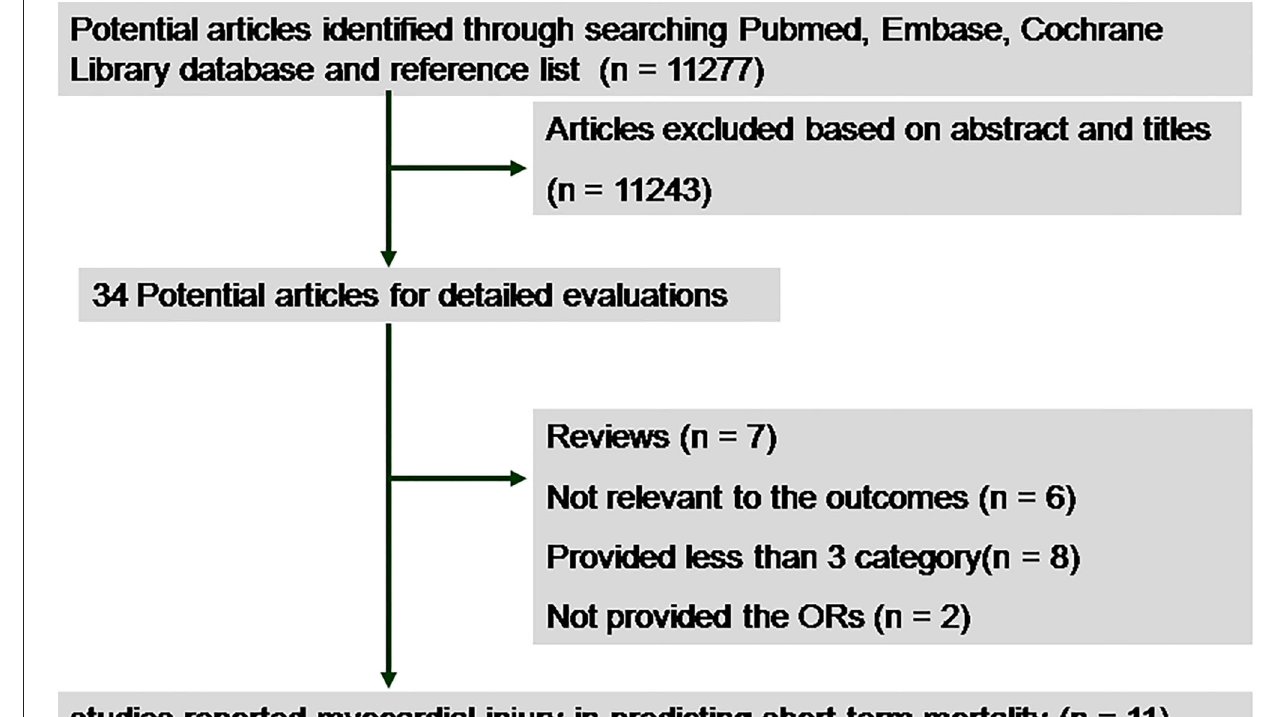
FIGURE 1 | Flow chart of the trial selection process. OR, odds